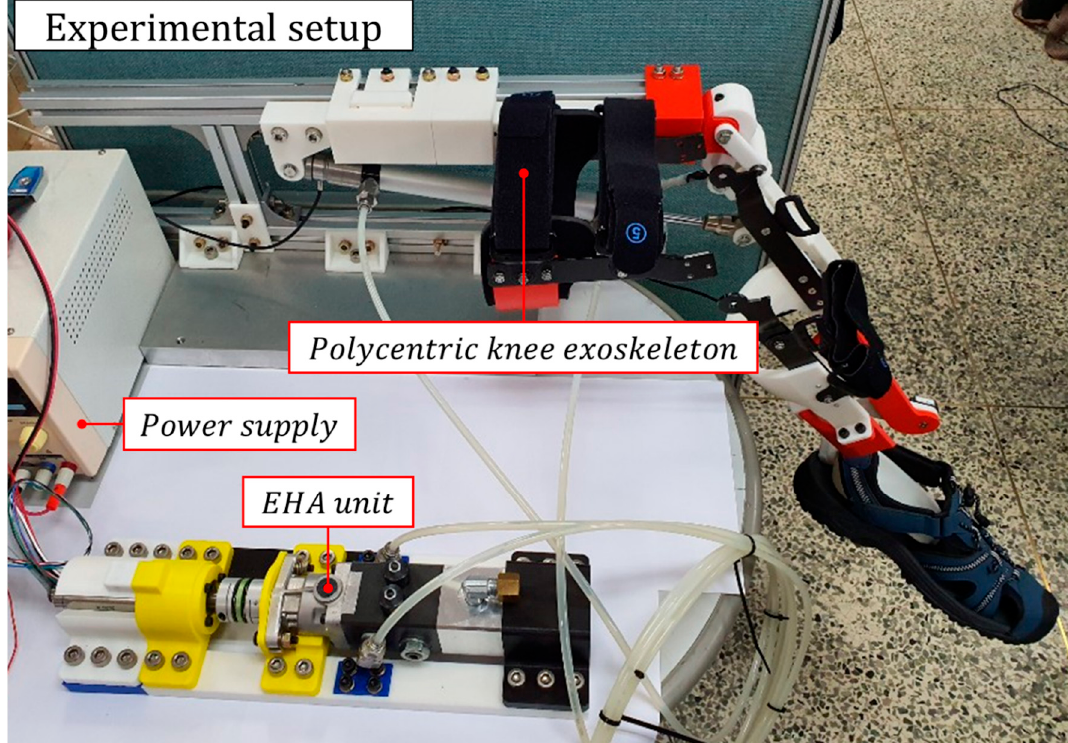
Figure 10. The overall experimental setup attached to a rigid body .